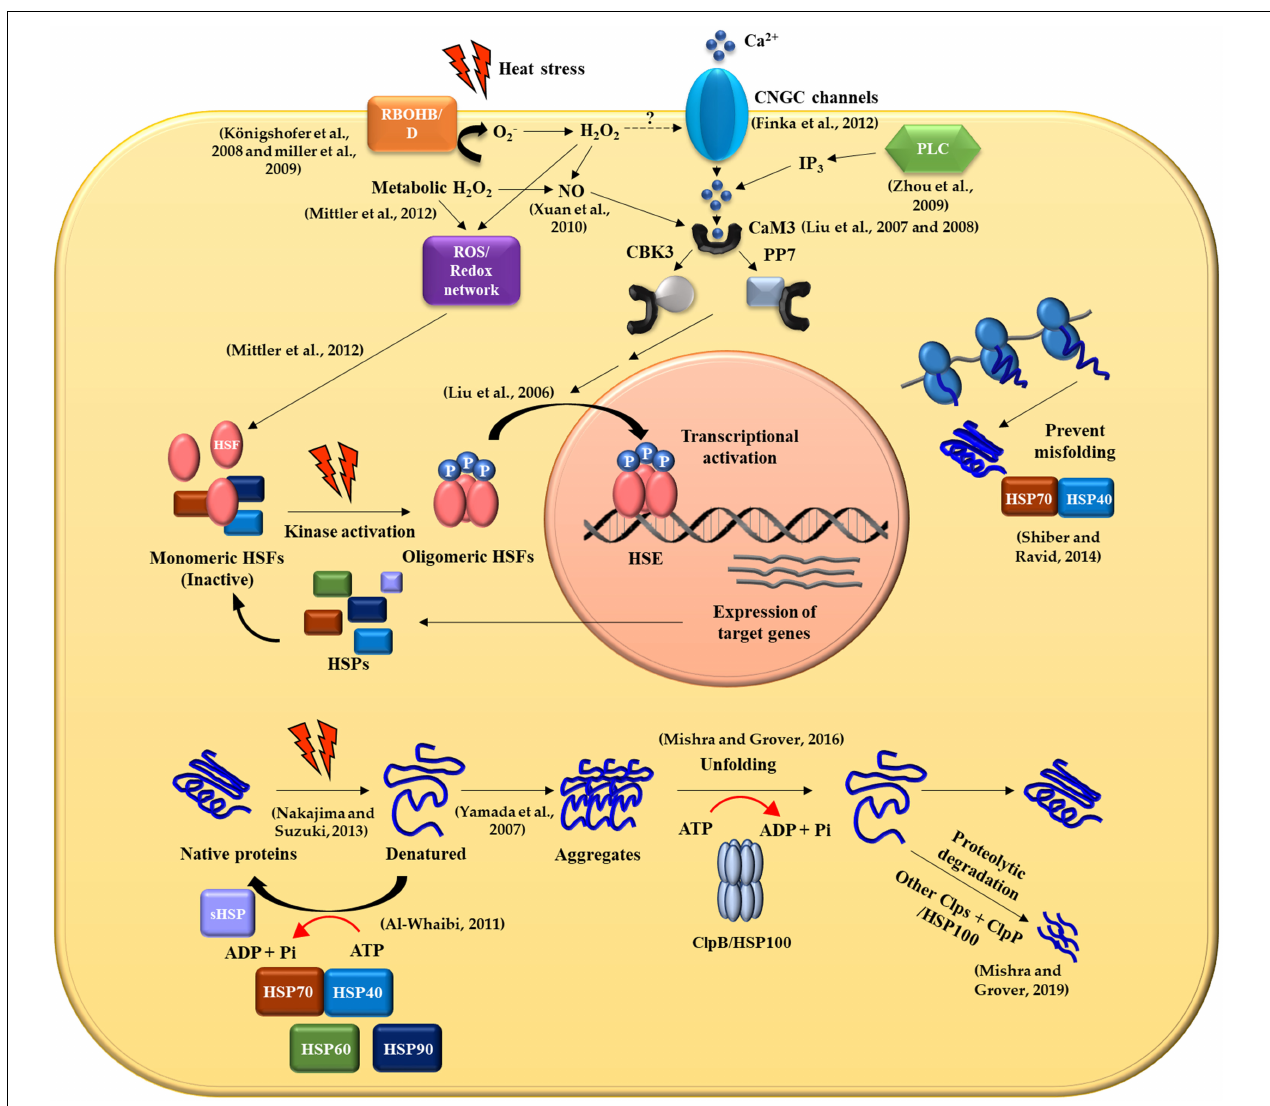
FIGURE 1 | General molecular mechanism of heat shock protein production and transcriptional regulation in response to heat stress in plant cells.